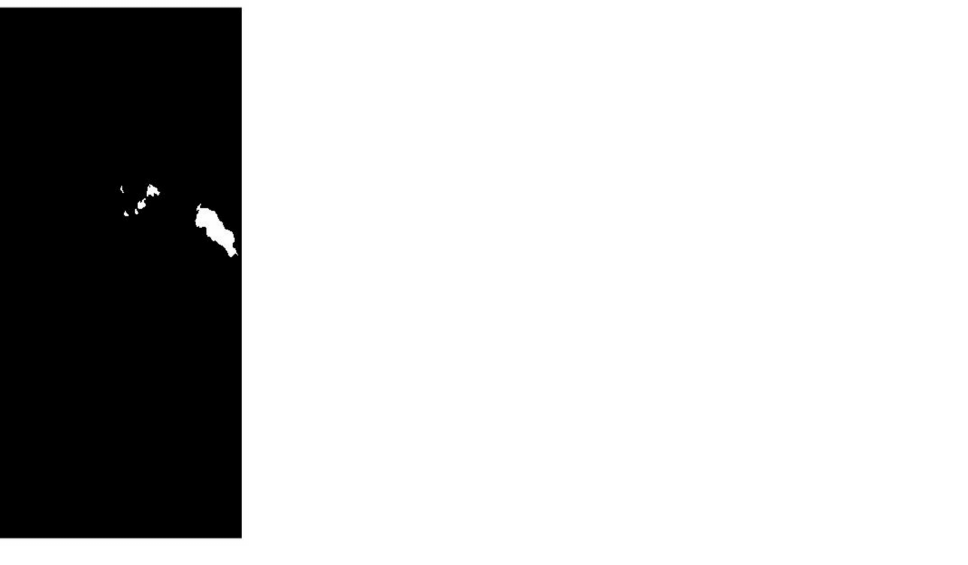
Figure 11. True oil spill pixels for binary image are marked manually. White represents oil spill pixels, while black represents non-oil spill pixels. Table 7. The experimental results of four deep learning models for dataset 4.